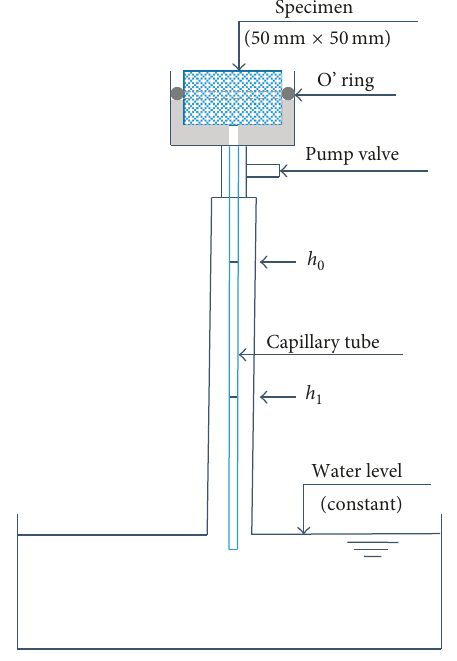
Figure 4: Air permeability apparatus (Thenoz method) [15–17].